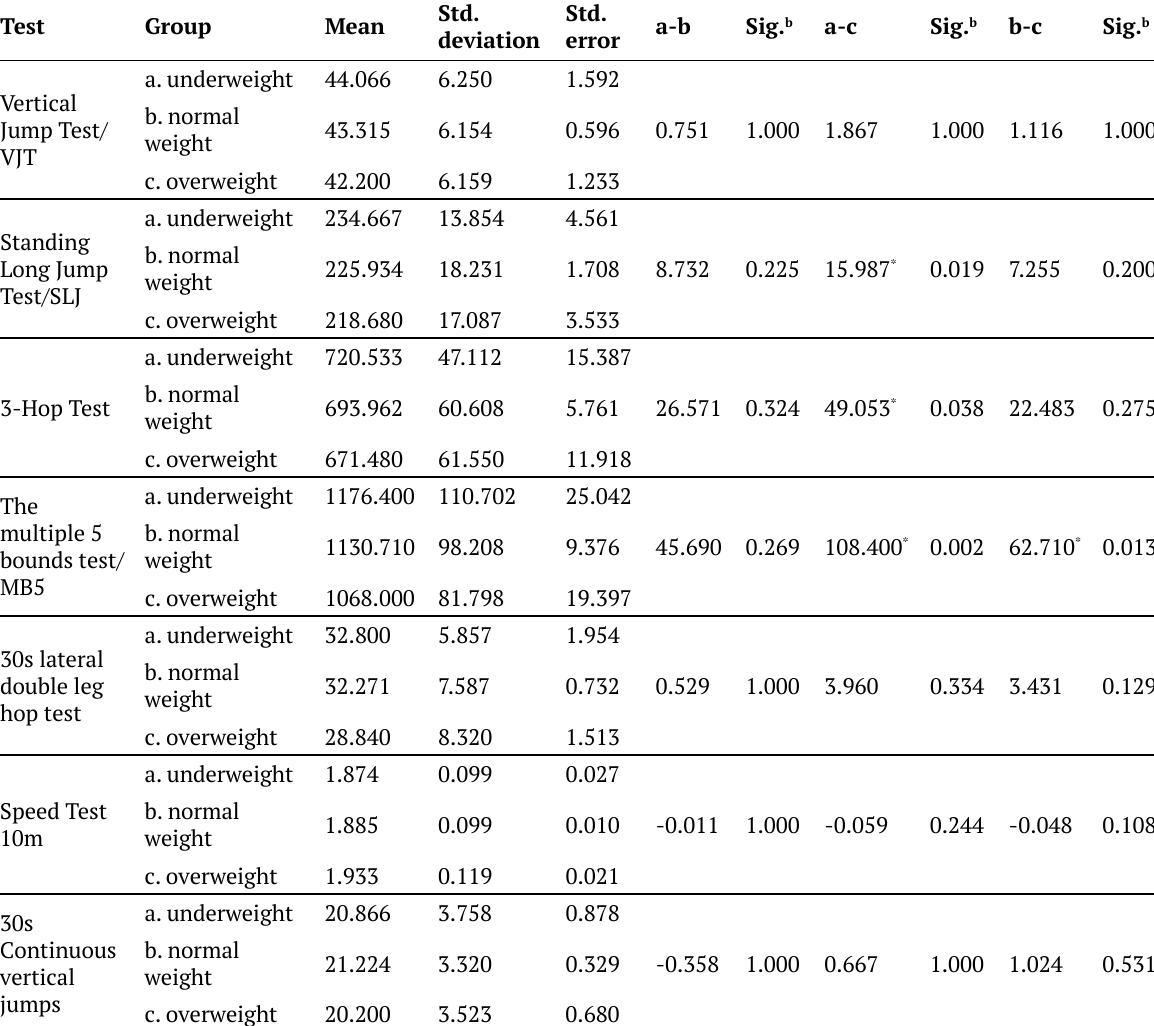
Table 5. Synthesis of average values and differences obtained between the 3 BMI categories for lower body explosive strength (underweight=15, normal weight=107, overweight=25) Test Group Mean